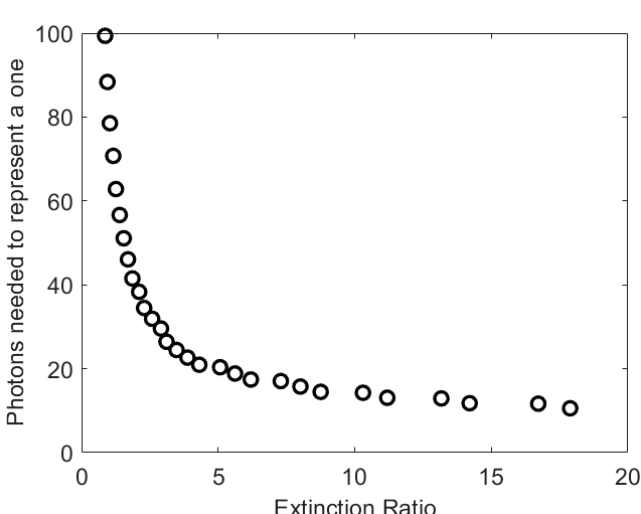
Figure 3. The impact of the extinction ratio of the transmitter on the number of photons per bit needed to represent a one and achieve a BER of 3.8 × 10 − 3 .